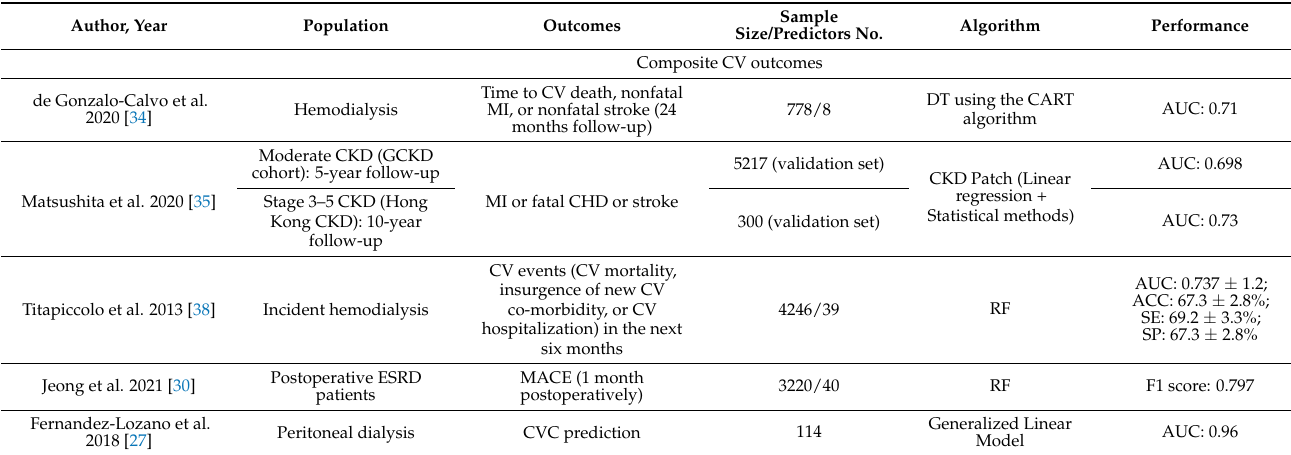
Figure 1. Study selection process and number of papers included in the systematic review. Table 1. Summary of the included